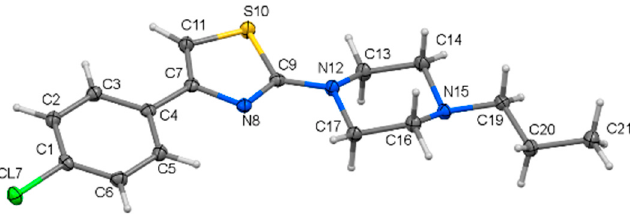
Figure 1. Molecular structure of ligand L2.